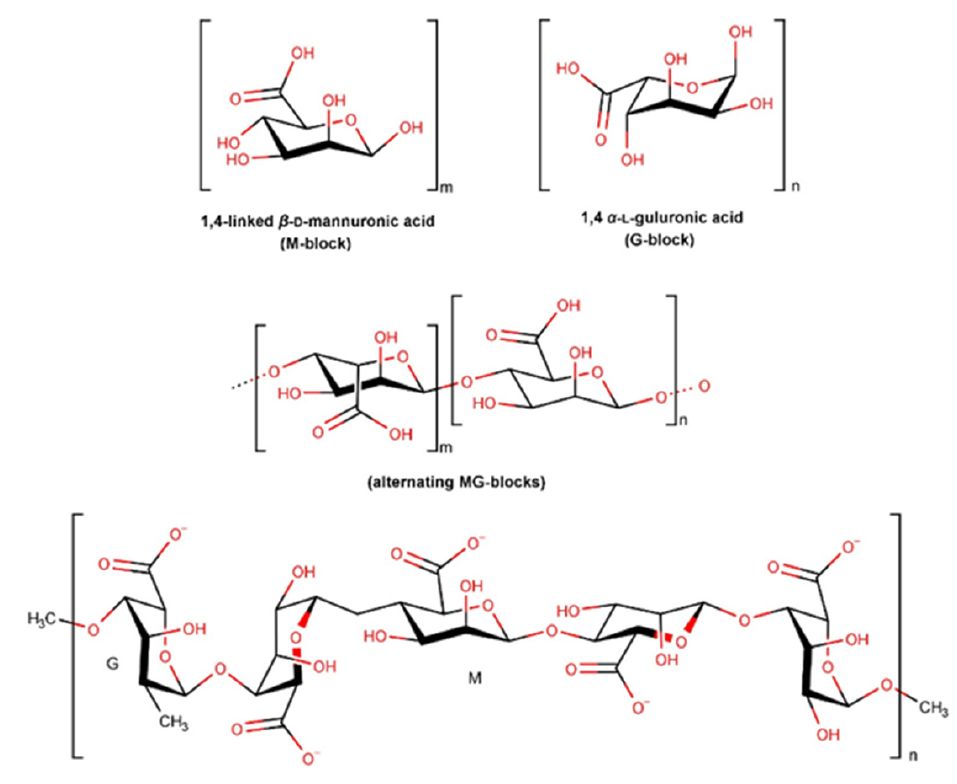
Figure 15. Chemical structure of alginate and respective monomers.